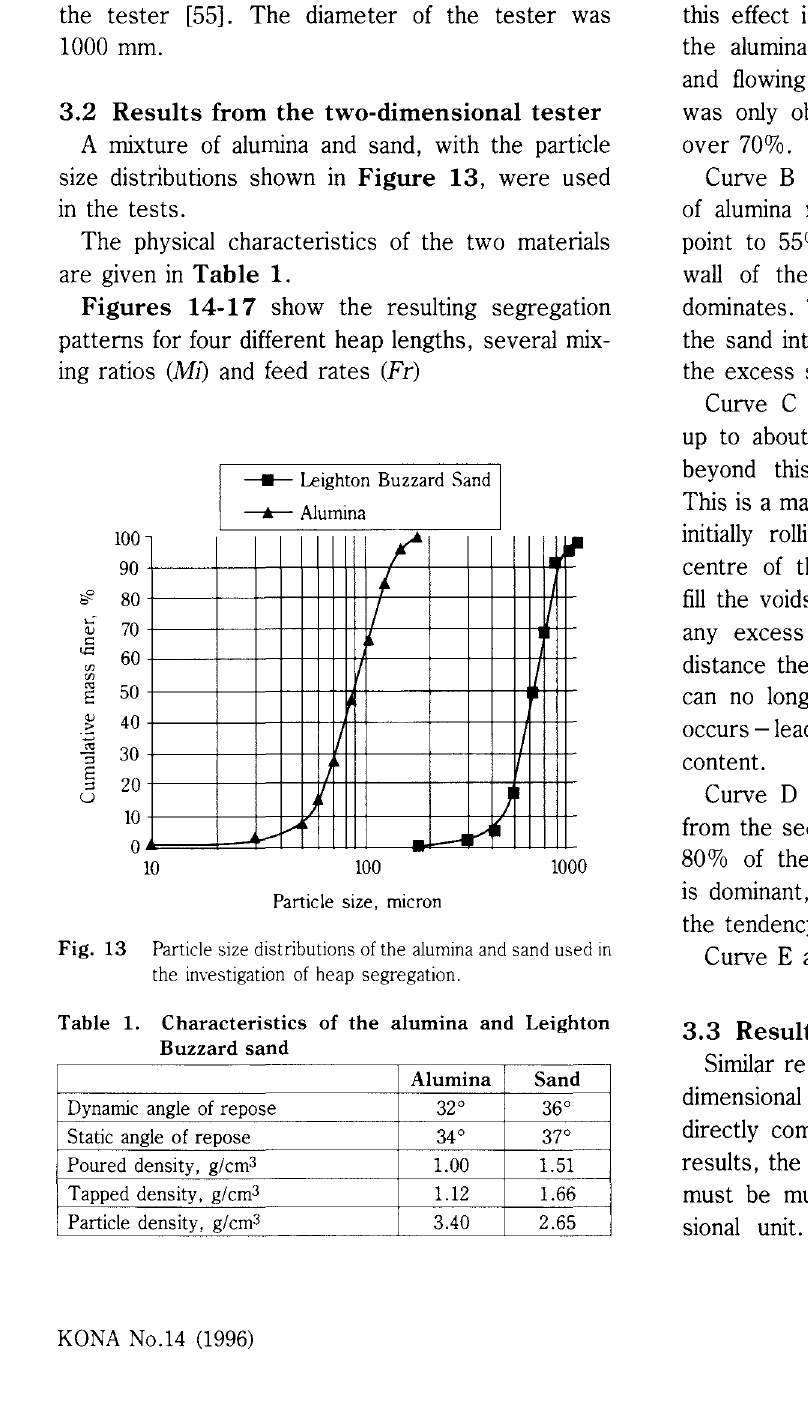
Fig. 13 Particle size distributions of the alumina and sand used in the investigation of heap segregation. Table 1. Characteristics of the alumina and Leighton Buzzard